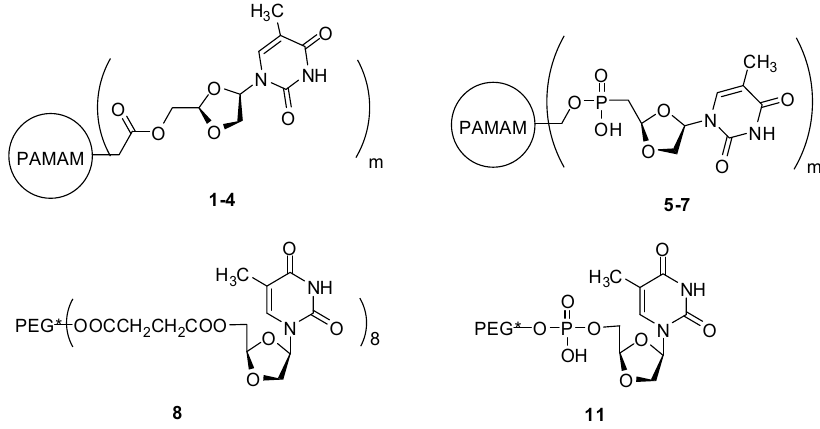
Figure 13. Dendrimer prodrugs potentially active in HIV [64].